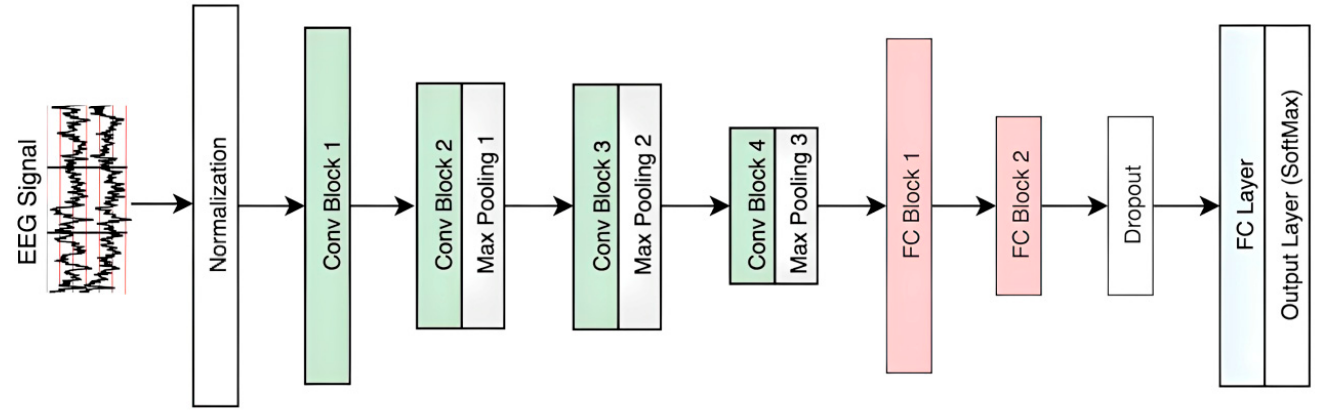
Figure 5. Proposed CNN Model for EGG-based Recognition.